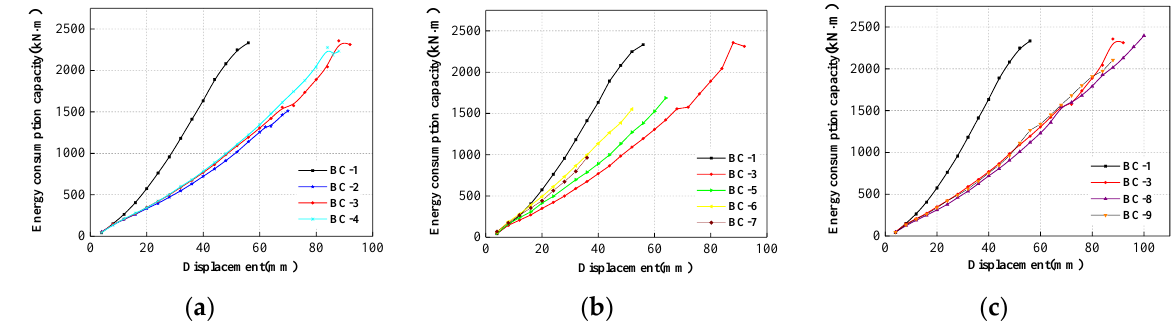
Figure 10. Energy dissipation capacities of joint specimens. ( a ) Stirrup ratio group; ( b ) Axial pressure ratio group; ( c ) Concrete strength group.